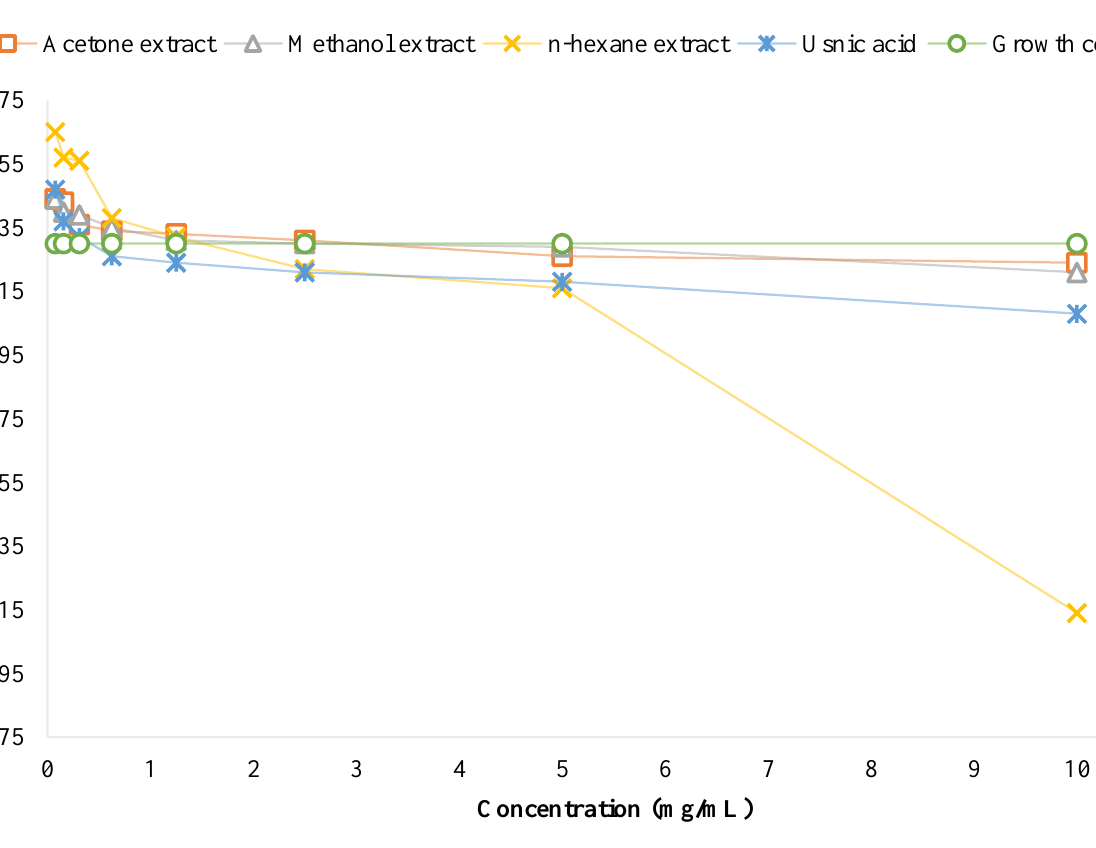
Figure 3. The impact of the tested extracts and usnic acid on the metabolic activity of P. aeruginosa biofilm.